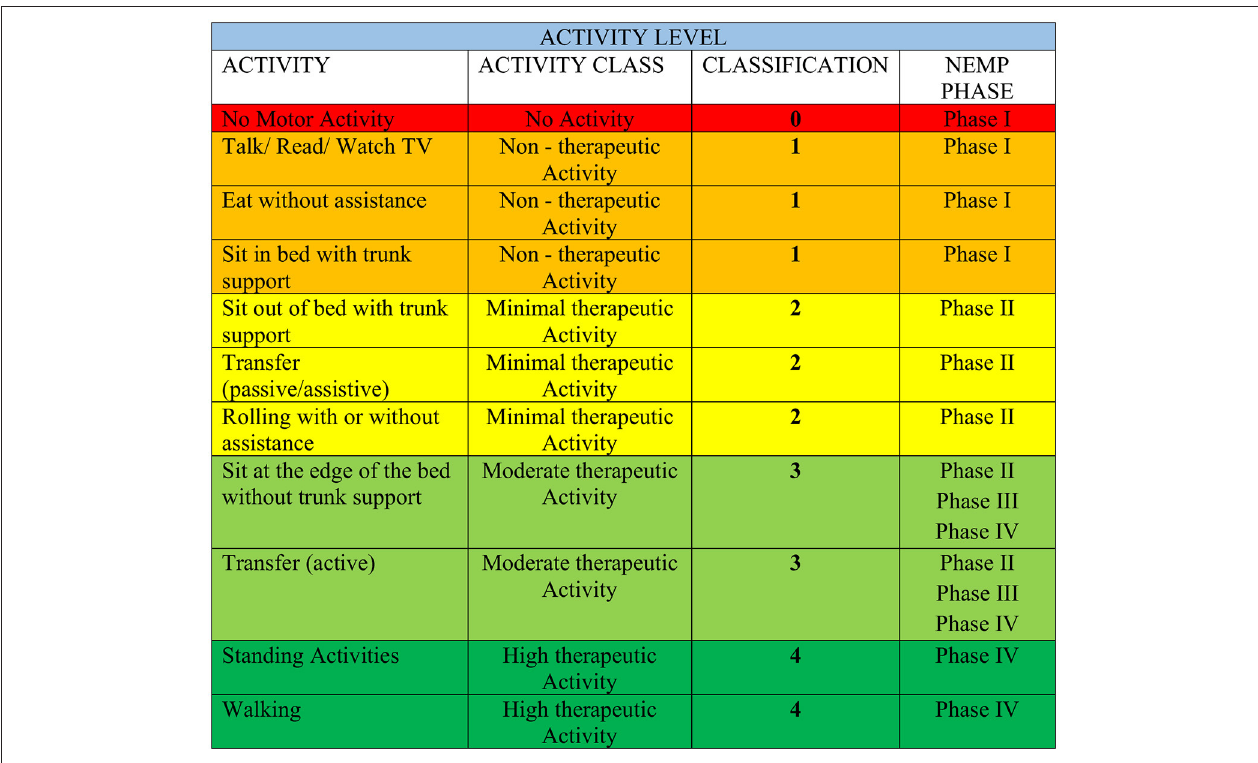
FIGURE 2 | Activity Level category adapted from Bernhardt et al. (3). The colors organized in AL are in accordance with those in Figure 1 of the